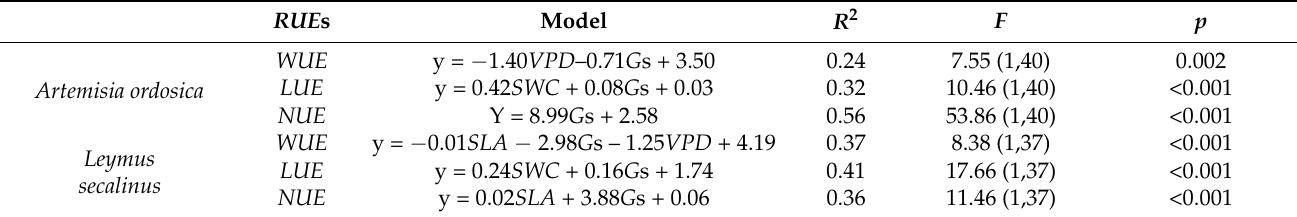
Table 1. Results of stepwise regression on the relationships between RUE s and the biophysical factors associated with A. ordosica and L. secalinus .